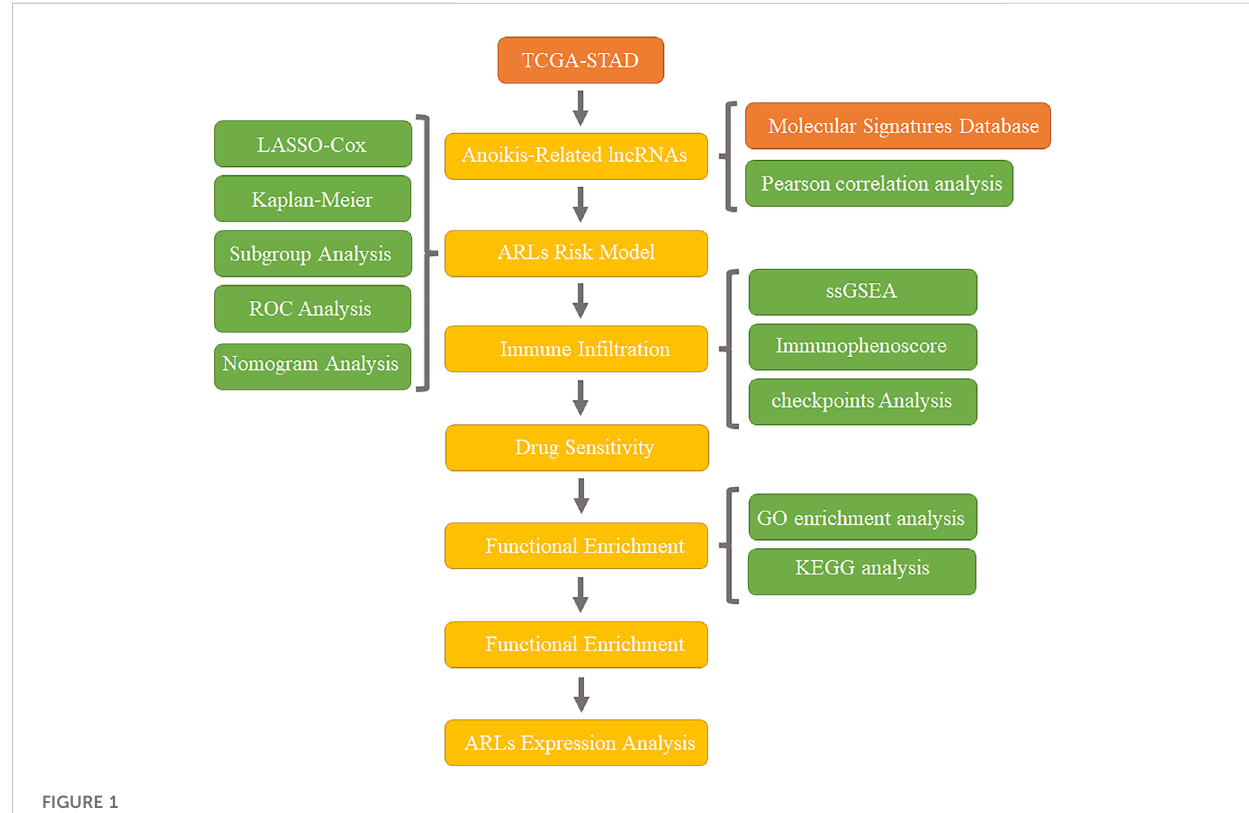
FIGURE 1 Work fl